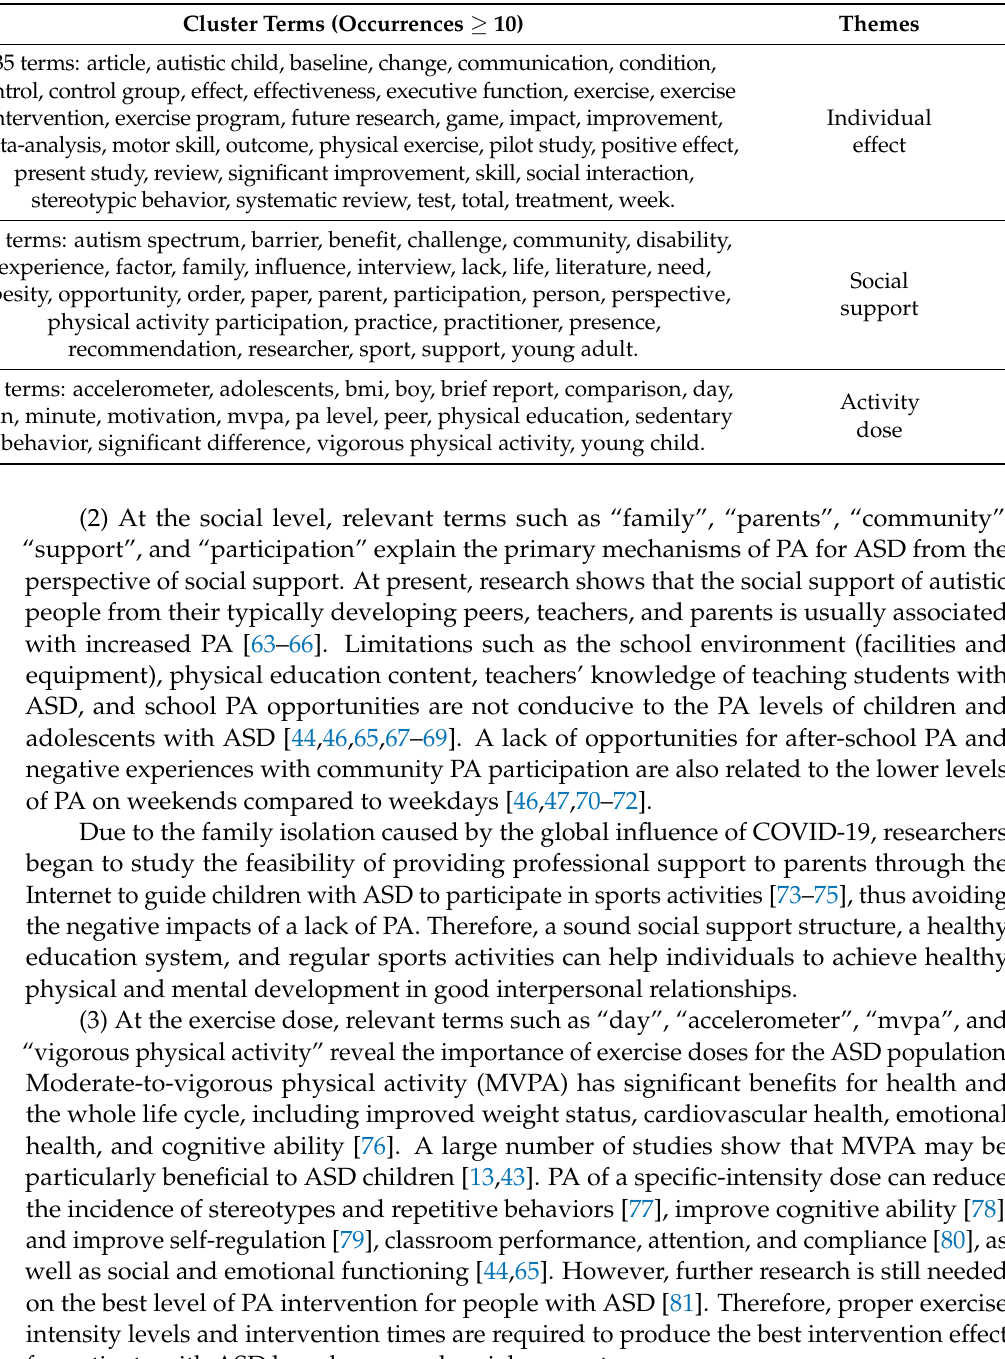
Table 6. The main terms are identified based on the clustering